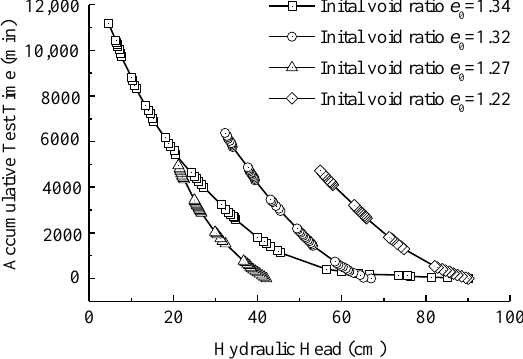
Figure 1. Falling-head permeability test results.